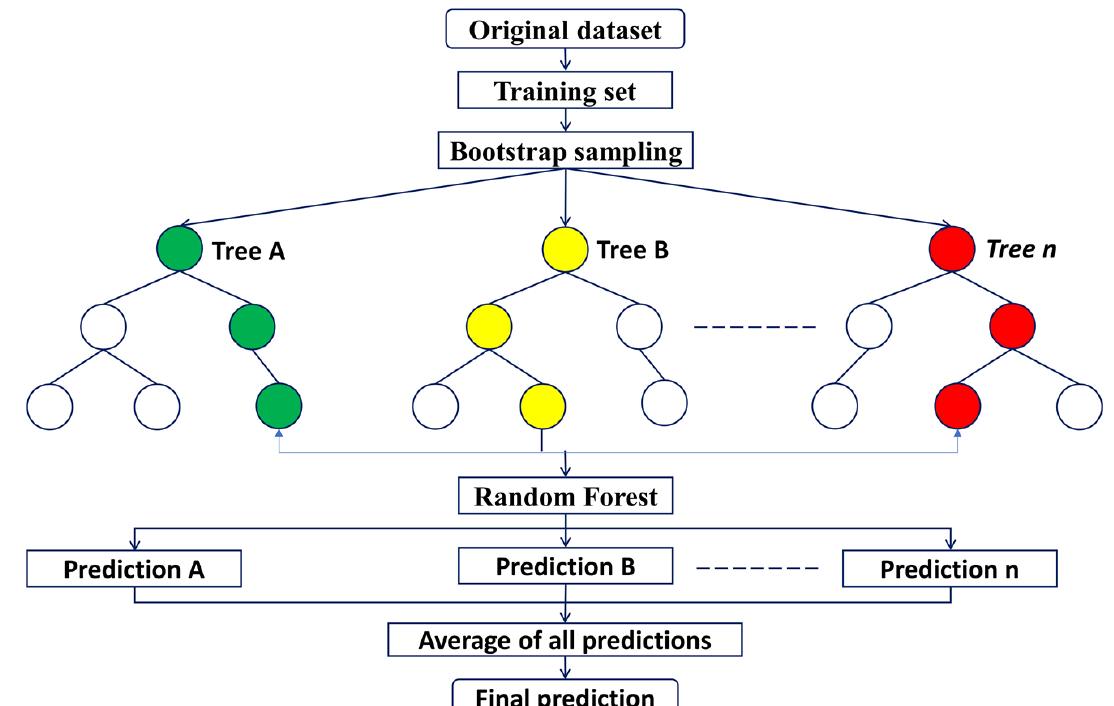
Figure 5. Illustration of random forest prediction.